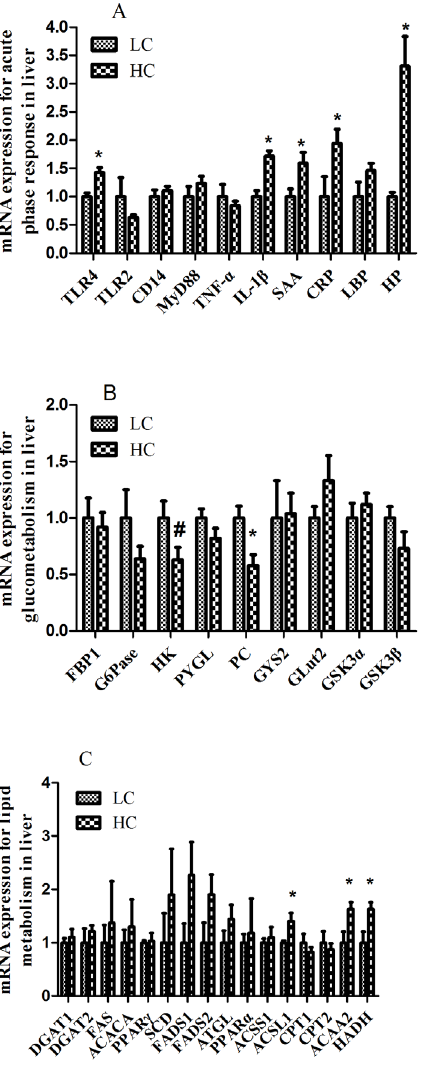
Figure 5. Hepatic gene expression profile detected by real-time PCR. (A) mRNA expression of the key genes for inflammatory response and acute phase responses. (B) mRNA expression of the key genes for glucometabolism. (C) mRNA expression of the key genes for lipid metabolism. Beta-actin was used as the reference gene for gene expression. Values are mean 6 SEM. # p , 0.1 , * p , 0.05 vs. LC.